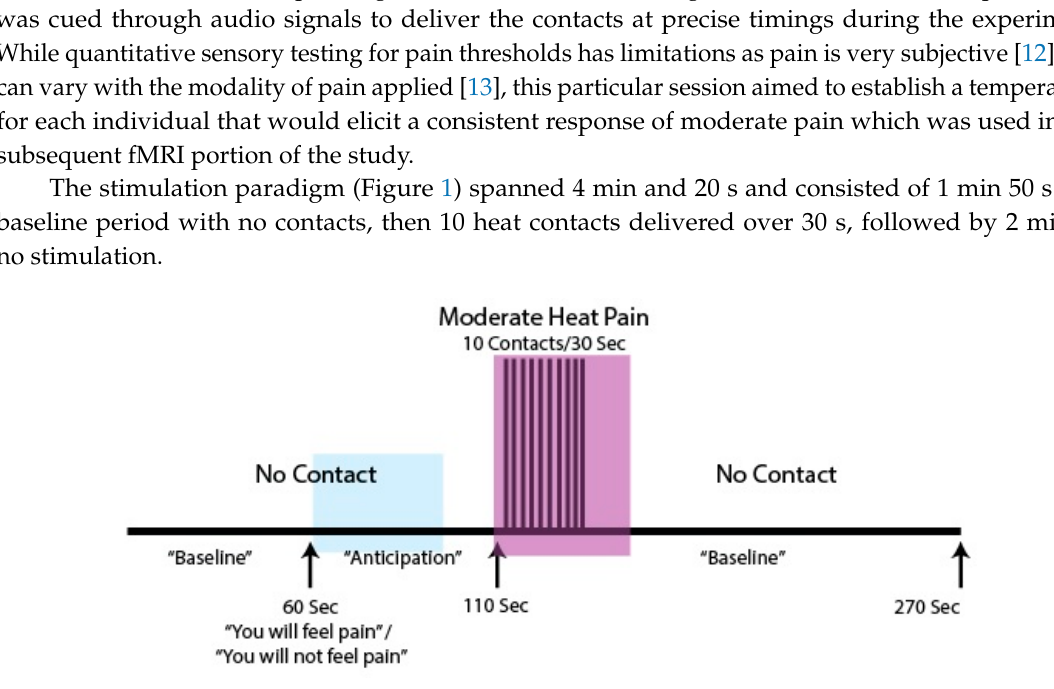
Figure 1. Task paradigm for the expecting pain data. Highlighted areas indicate periods analyzed in the current study, with the blue highlighting indicating the ‘expectation’ period (after participants were told whether or not a painful stimulus would be applied) and purple highlighting indicating the ‘stimulation’ period (where participants were either experiencing a painful stimulus, or not experiencing a stimulus.